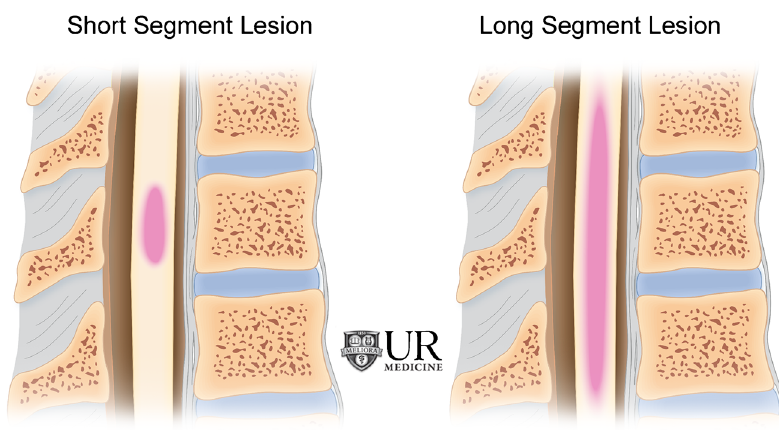
Fig. 3 Differentiating intramedullary pathology: short segment (left) versus long segment (right)